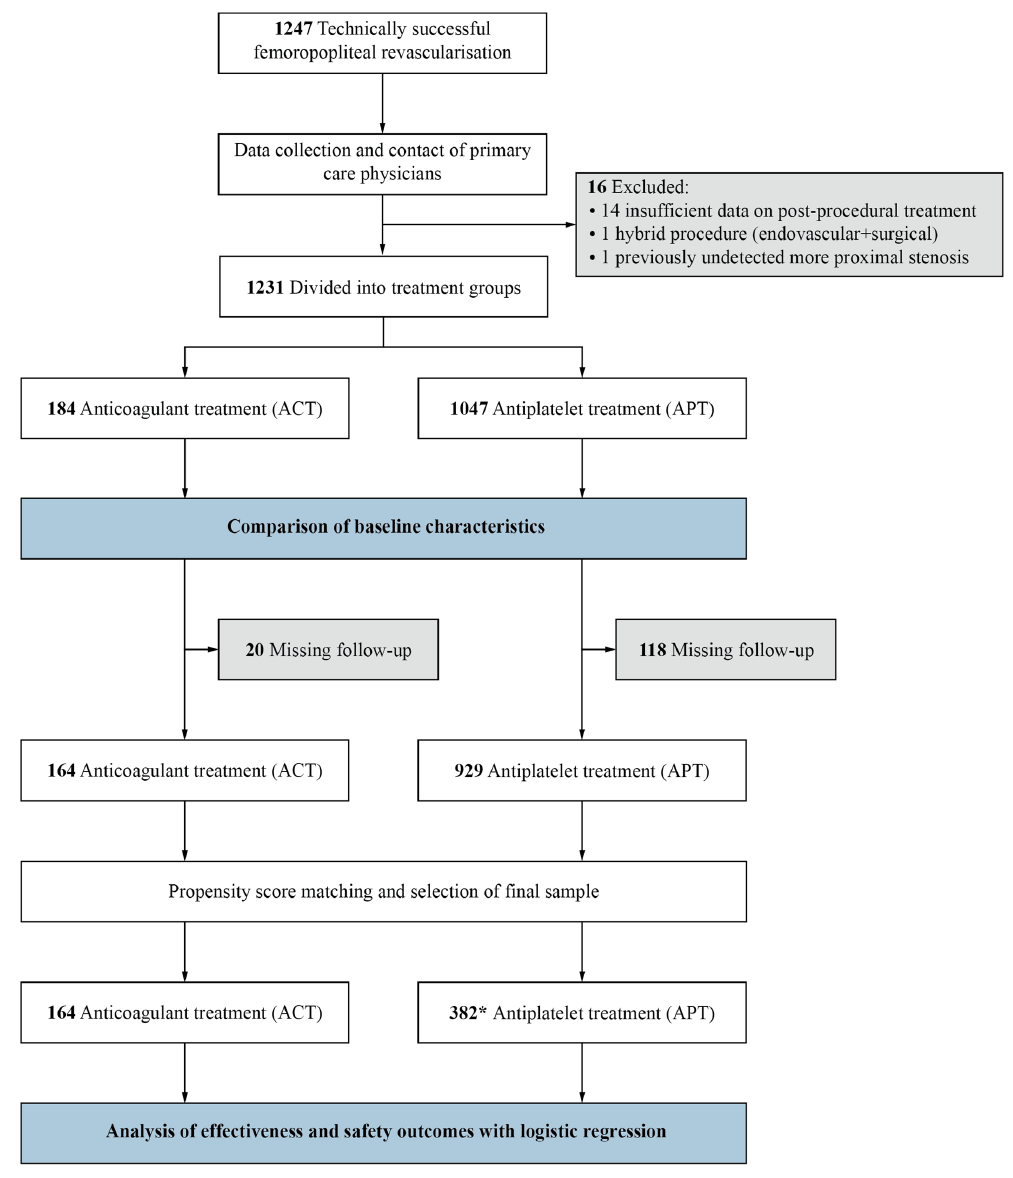
Figure 1. The studied patient profile, process of exclusion, and analysis. * is the number of matched patients, not considering the patients’ statistical weights. The effective sample size was 243.1